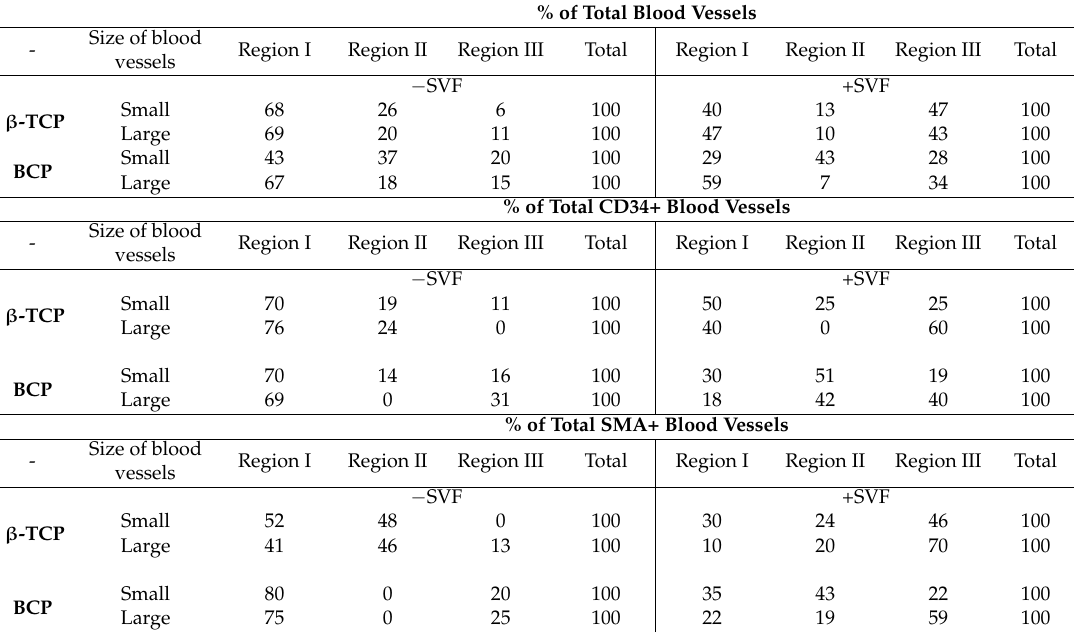
Table 2. Percentages of small and large blood vessels in the scaffold area subregions (regions I, II, and III) from maxillary bone biopsies obtained from patients treated with β -TCP and BCP without stem cells ( − SVF, n = 3) and with stem cells (+SVF, n = 5) by histomorphometrical